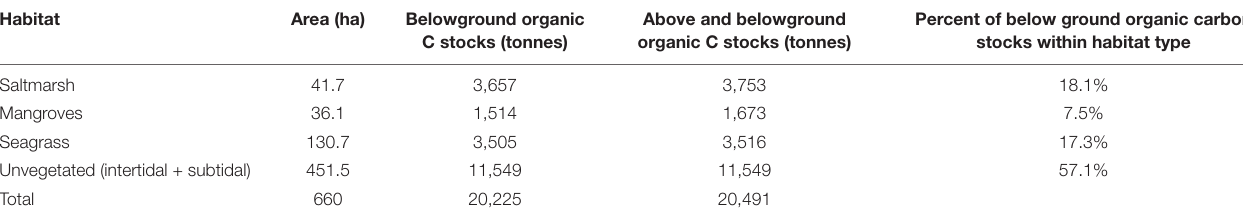
TABLE 3 | Habitat area and total estimated organic carbon (100 cm depth) within each habitat type.